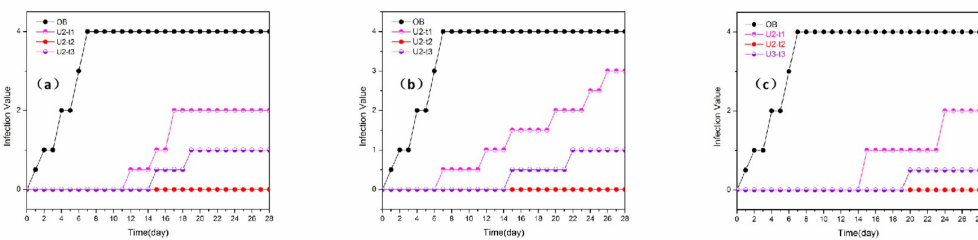
Figure 7. The infection value within 28 days of bamboo samples with di ff erent treatment conditions against ( a ) Trichoderma viride , ( b ) Aspergillus niger V. Tiegh , and ( c ) Penicillium citrinum Thom